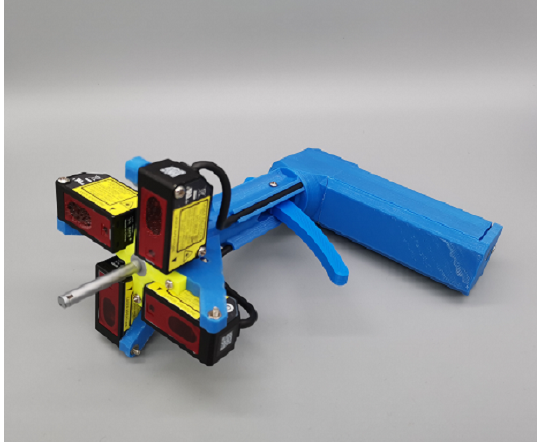
Figure 12. The calibration object: a handheld hole–verticality measurement